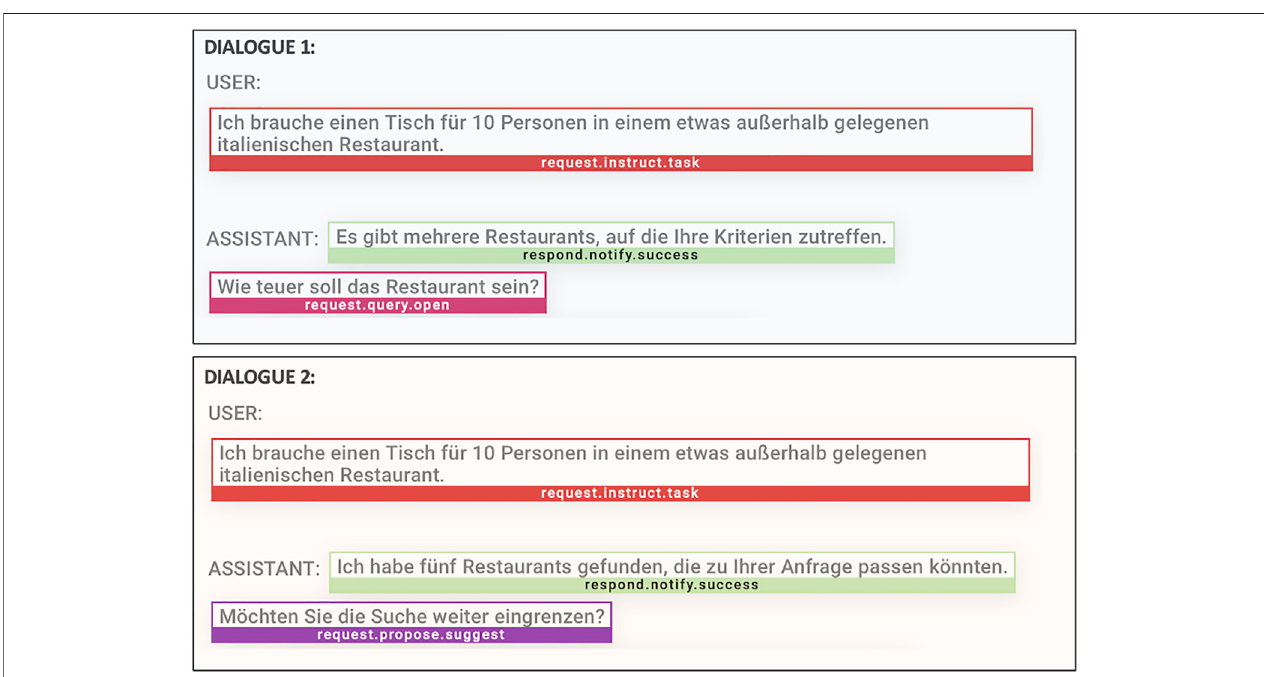
FIGURE 12 | Dialogue Act Sequence Similarity between turns elicited by same dialogue beginning: the two second turns share the fi rst dialogue act and differ regarding the second one resulting in a sequence similarity of 0.5.